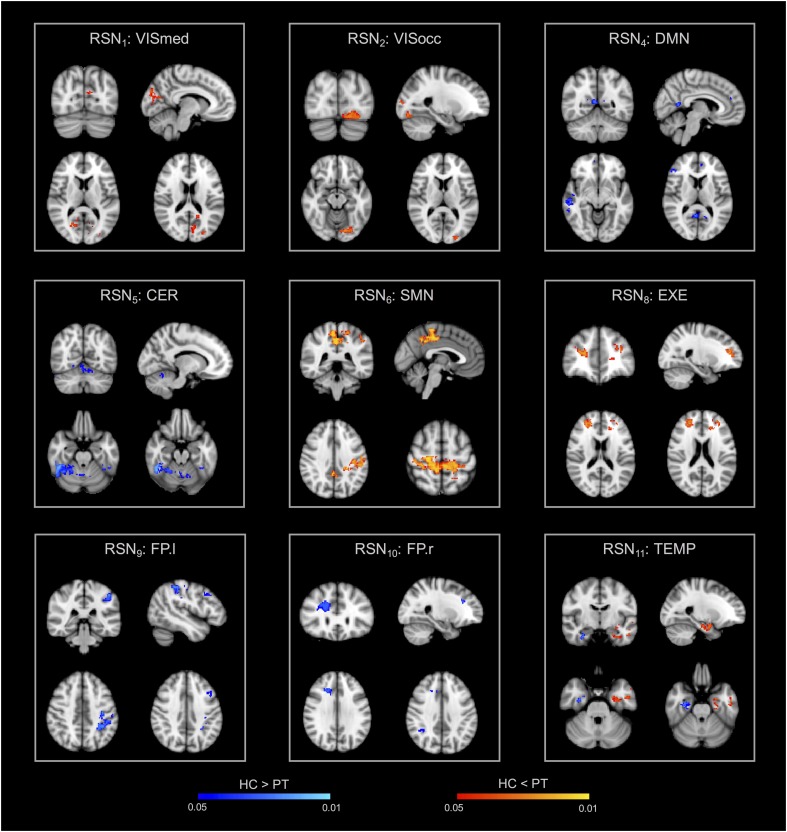
Within-network functional connectivity (FC) differences between patients and controls resulting from the permutation testing on the dual regression outputs. Clusters of significant difference (p < 0.05, FWE-corrected with TFCE) are overlaid on the MNI152 standard space and shown in radiological convention. In particular, areas featuring decreased FC in patients are reported with the blue-light blue colormap (HC > PT), while increased FC patterns in patients are decoded with the red-yellow colormap (HC < PT).